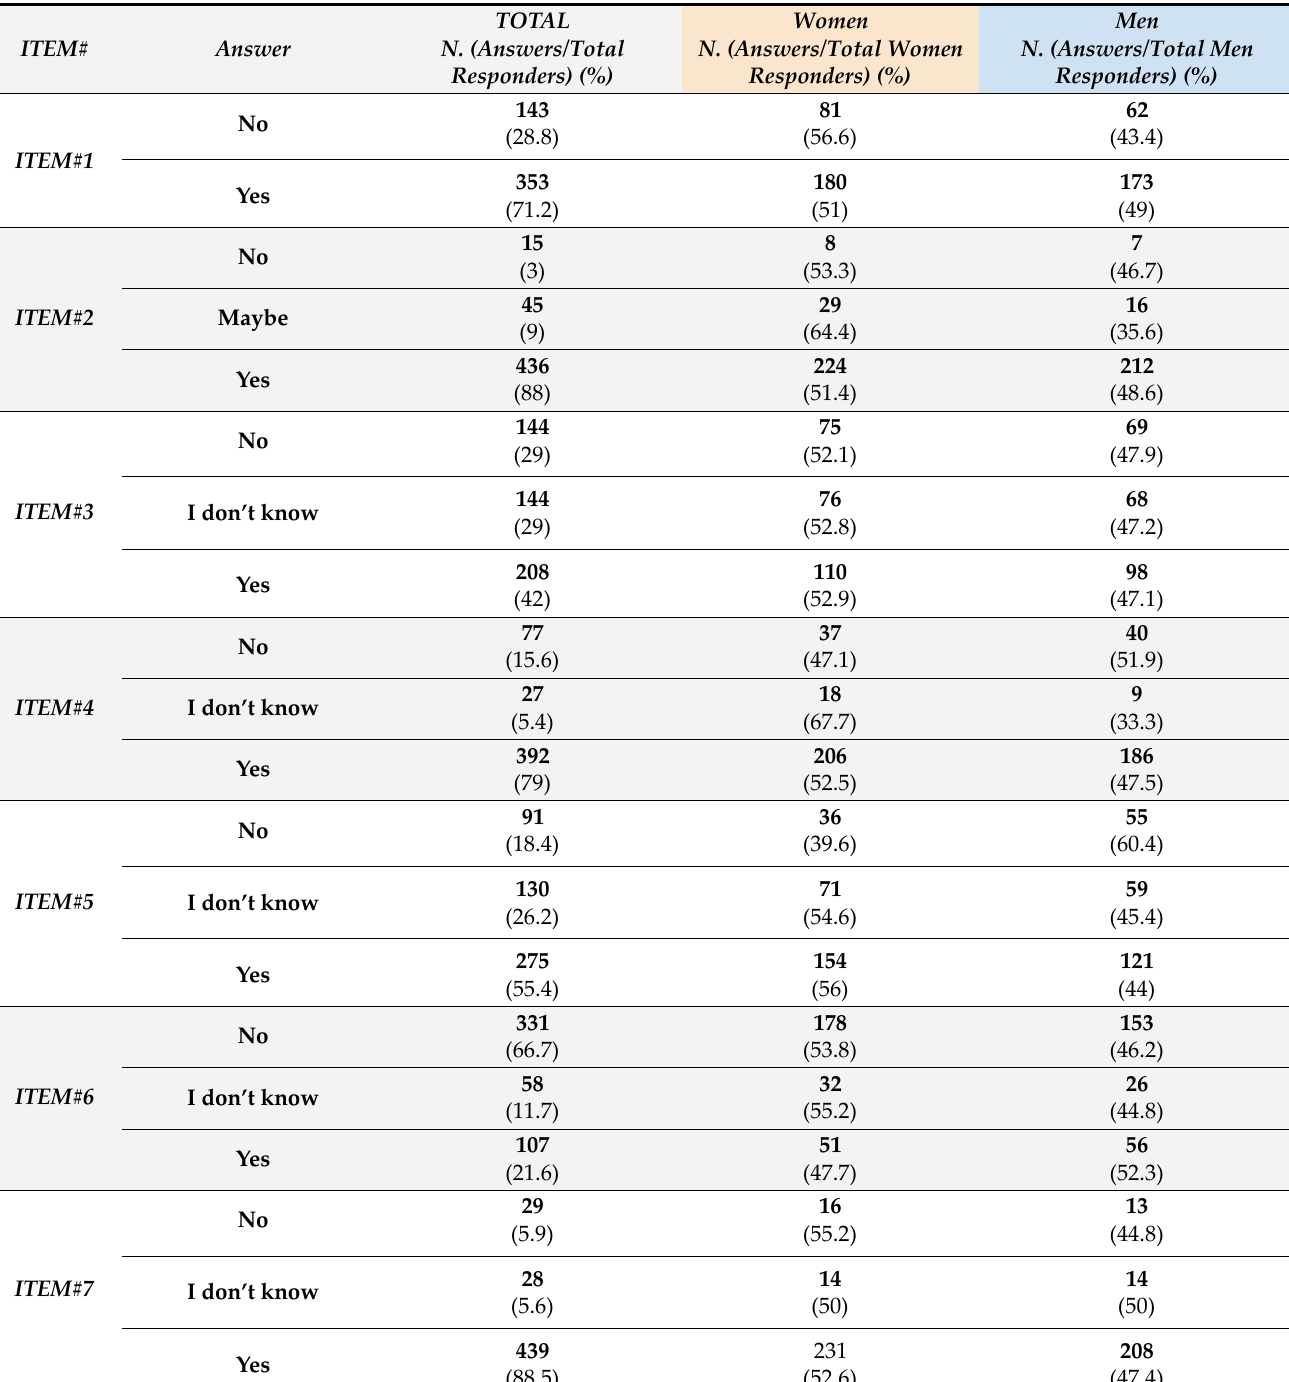
Table 4. Answers of respondents to the 9 items, differentiated by gender (* only for responders ‘No’ to item